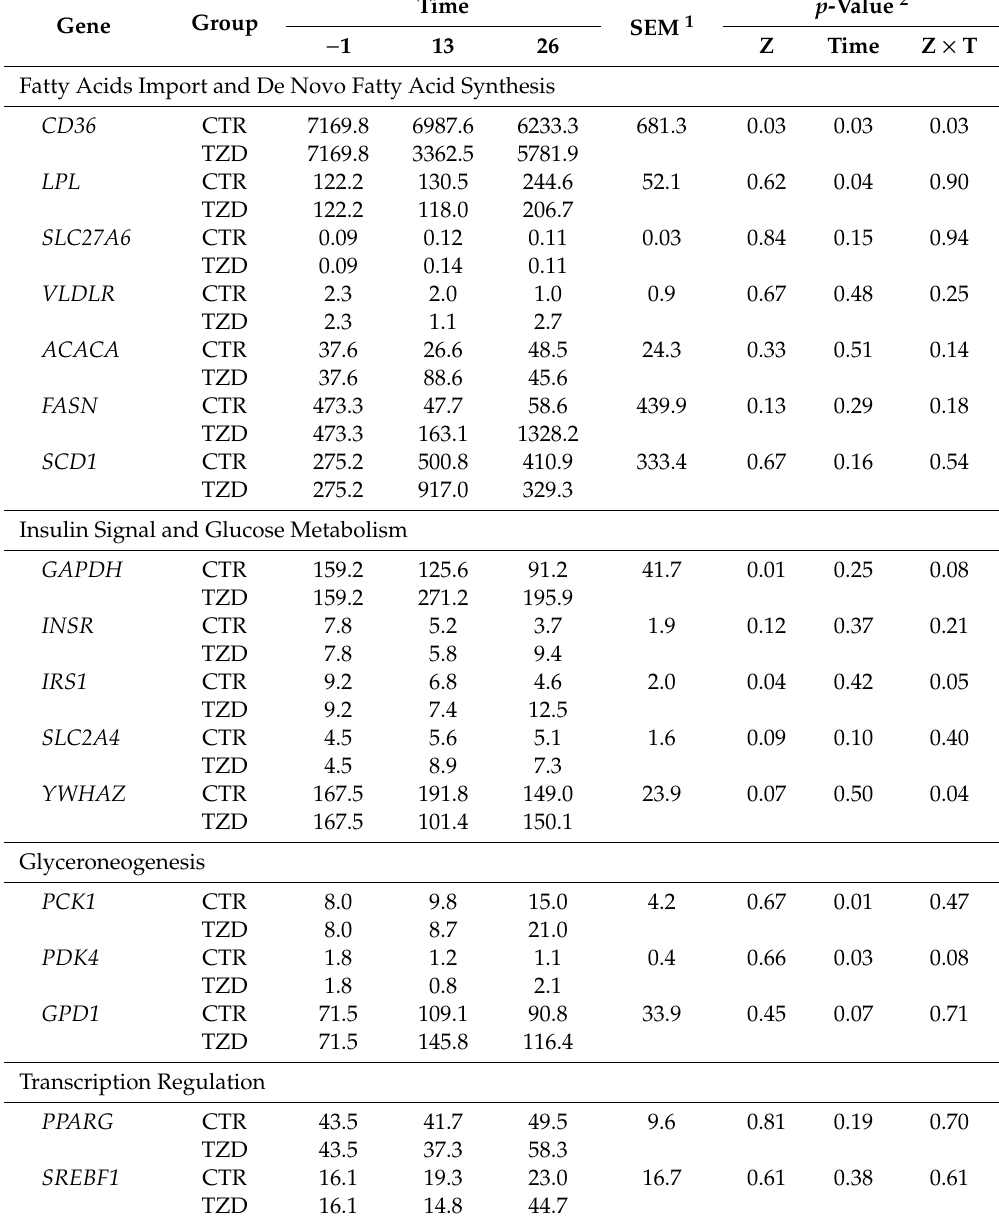
Table 3. mRNA abundance of selected genes in adipose tissue of goats treated with 2,4-thiazolidinedione (TZD) or saline (CTR). Samples were n ≥ 5 for both groups, except for the day 26 ( n = 3 for CTR; n = 6 for